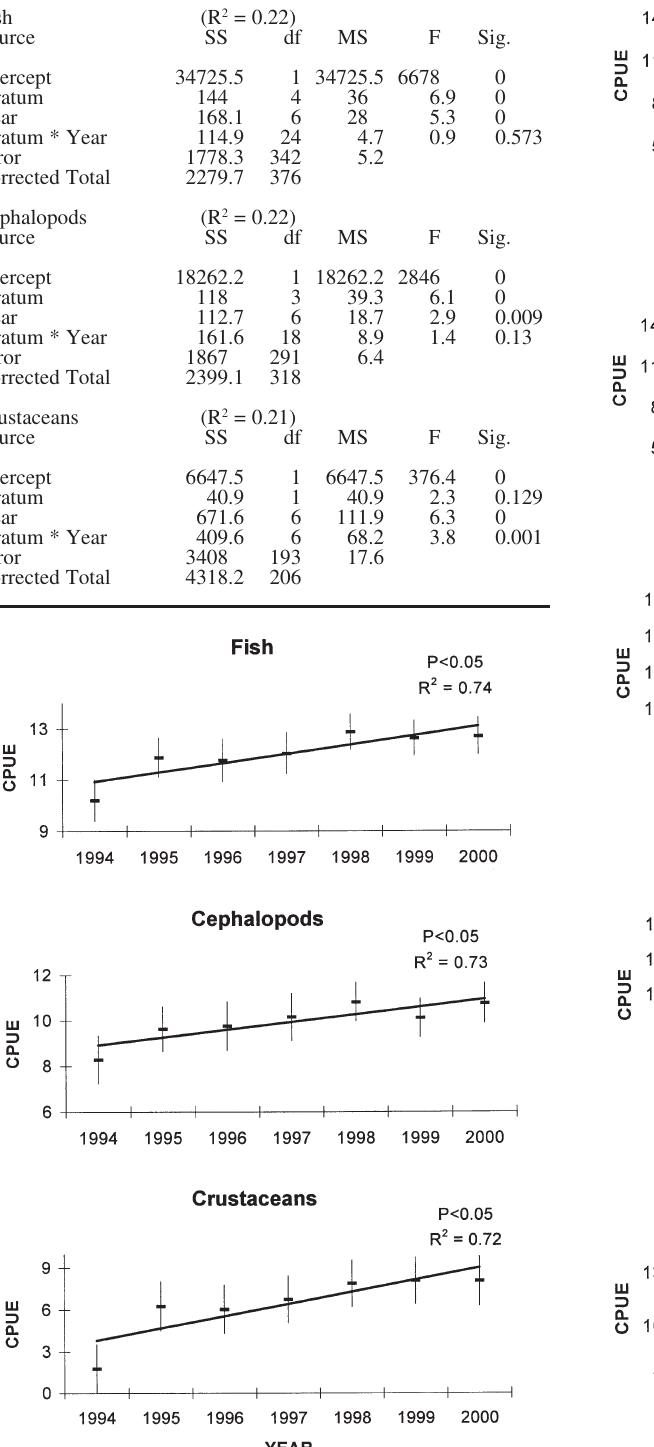
T ABLE 6. – ANOVA table for the GLMs fitted to each faunistic category. SS, Sum of Squares; MS, Mean Square. Fish